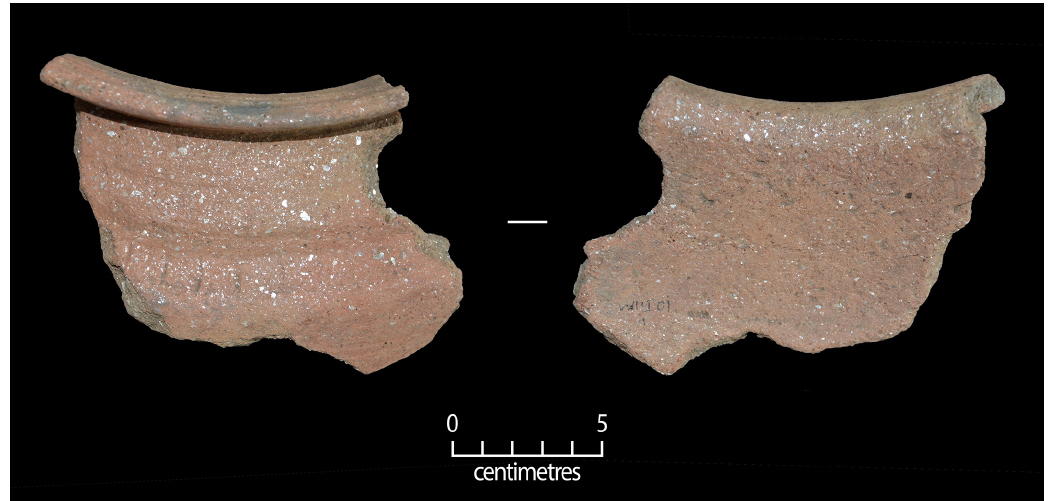
Figure 9: External and internal surface of a Class 4 variant 2 potsherd.